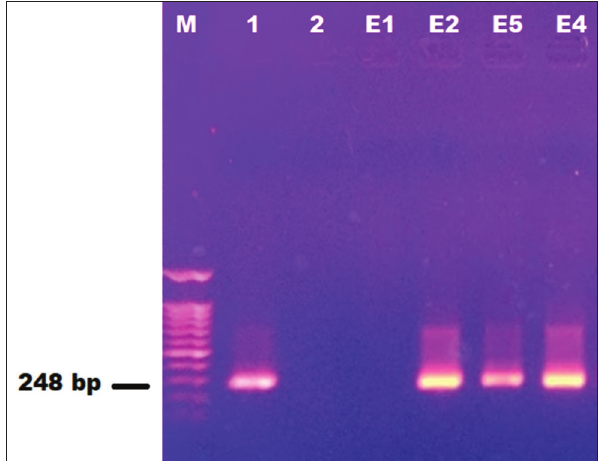
Figure-2: The presence of qacE gene among four E. coli chlorine-resistant strains. Lane M=100 bp ladder, lane 1=positive control, lane 2=negative control, lane E1=sample code O1 had negative result, lane E2=sample code O2 had positive result, lane E3=sample code O5 had positive result, and lane E4=sample code O4 had positive